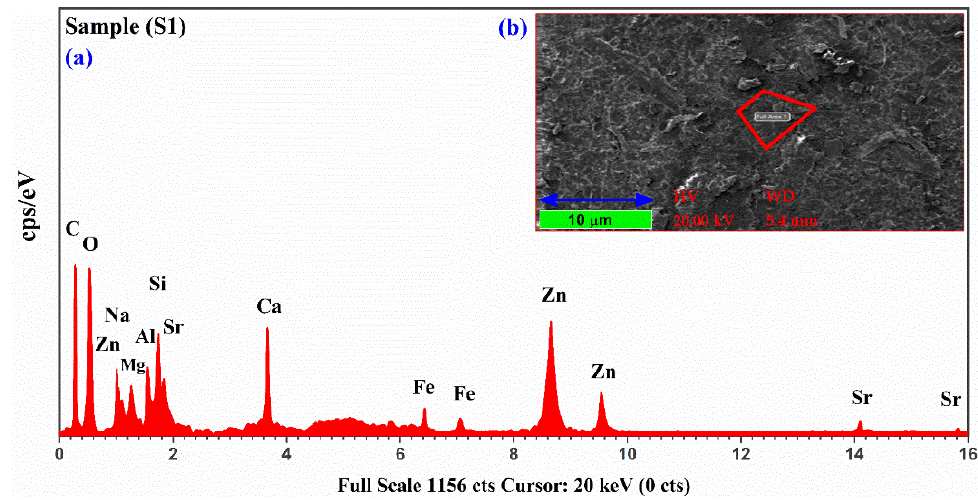
Figure 8. ( a ) Energy dispersive X-ray spectrum of the plant-biochar sample (S1); ( b ) shows the mi- crophotograph of the surface of the sample (S1) with a specific scanned area (red closed path).